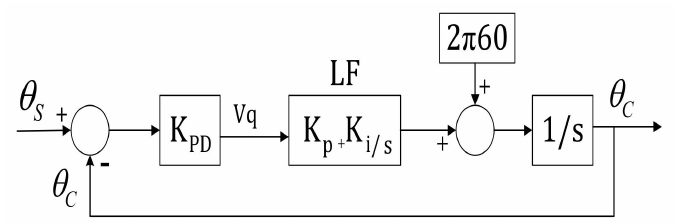
Figure 5. Linearized PLL